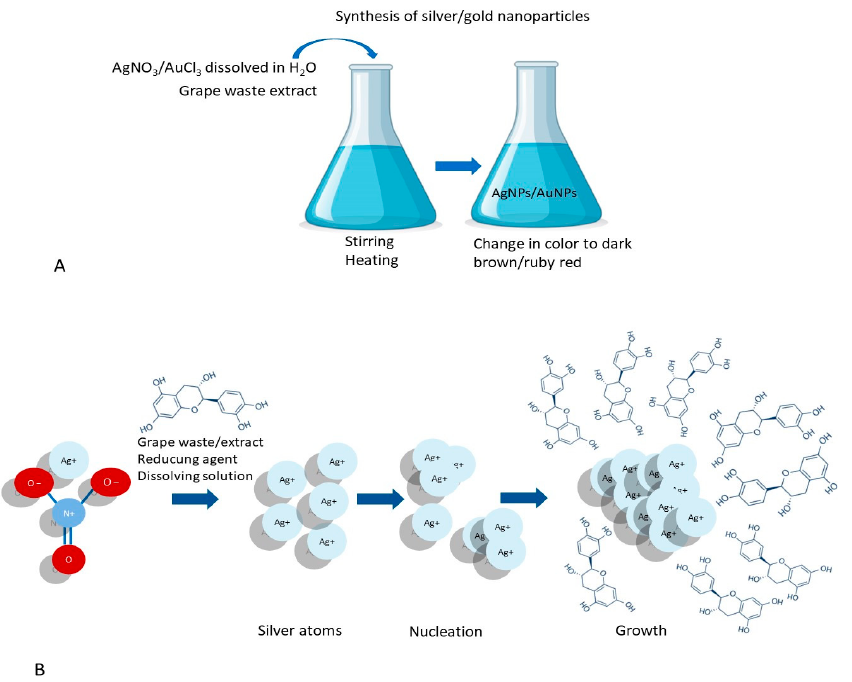
Figure 5. The synthesis of metal nanoparticles based on grape waste: ( A ) a general procedure; ( B ) the physicochemical process of forming metal nanoparticles. (Designed by Brgfx/Freepik).